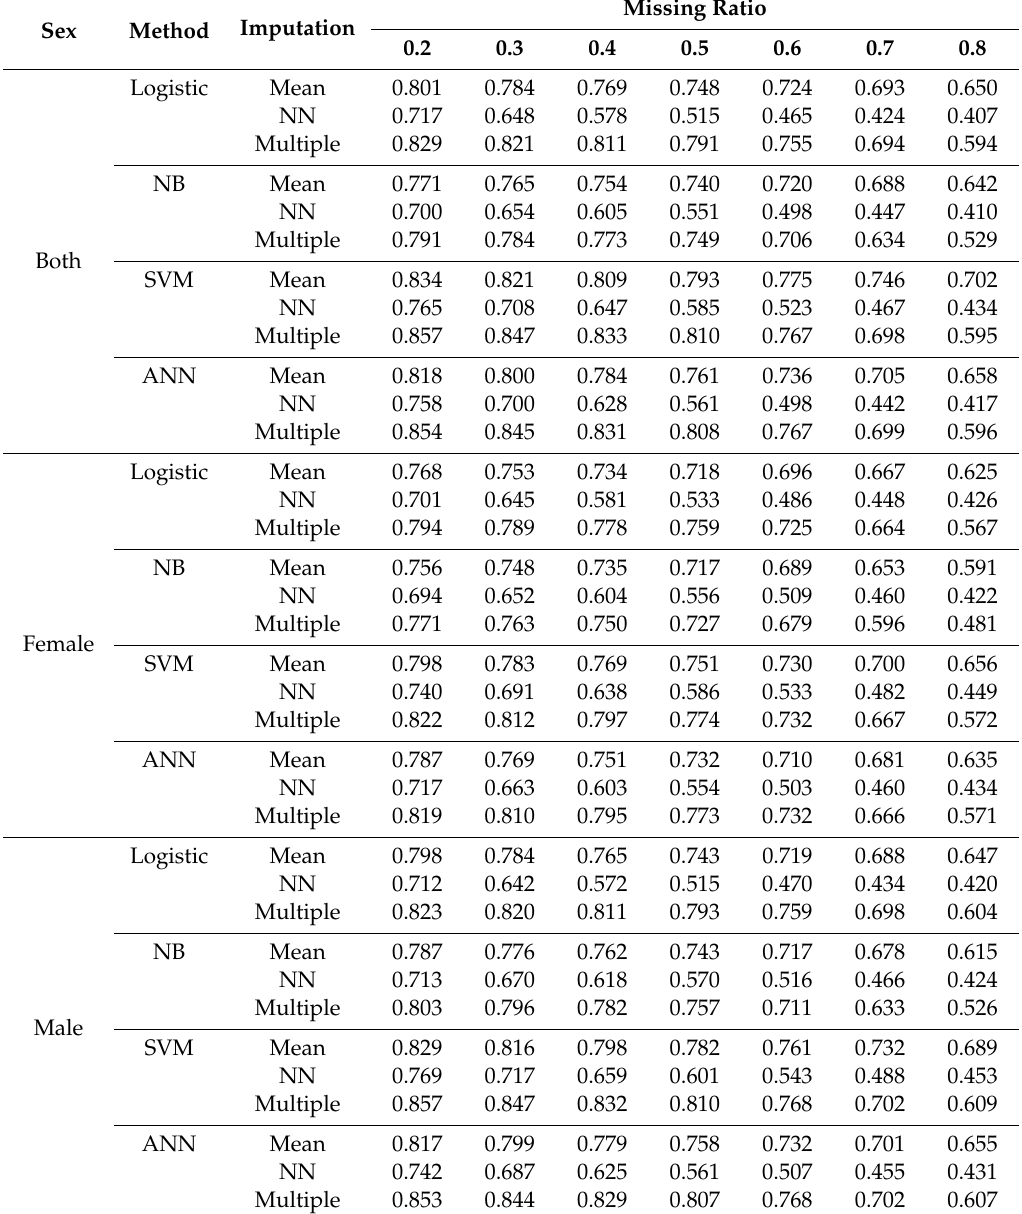
Table 4. Accuracy results by imputation method and learning algorithm: Upper / lower